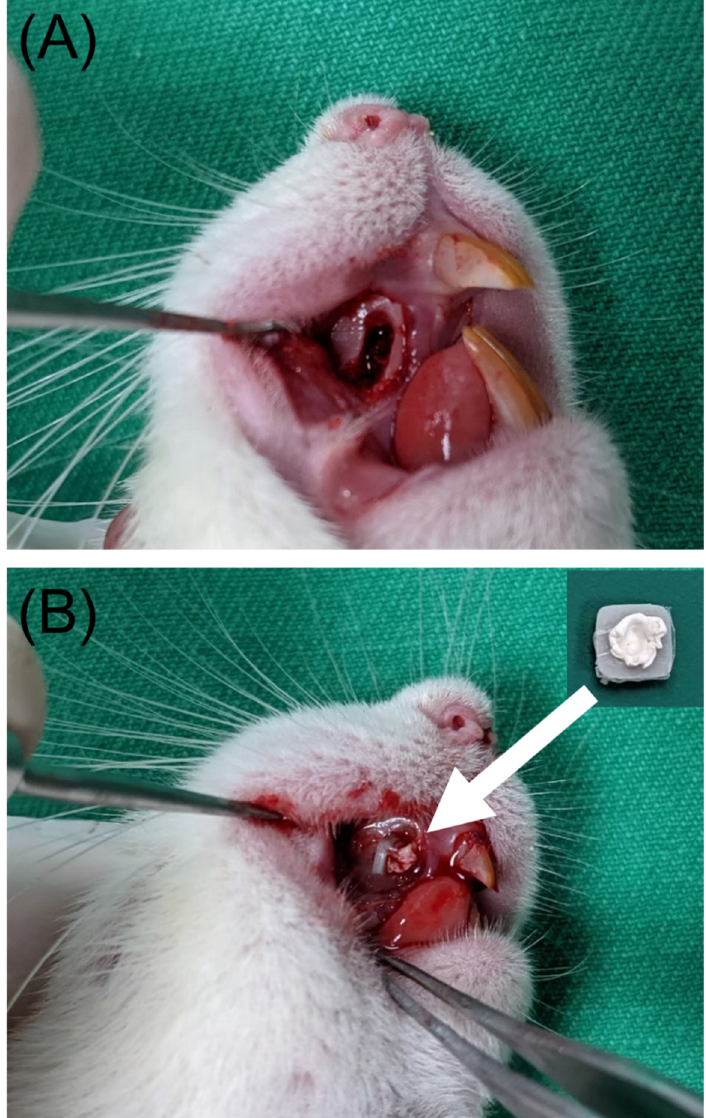
Figure 2. ( A ) Creating a bone cavity at the alveolar bone, ( B ) implantation of the drug- and biomolecule-incorporated nanofibrous scaffold in the bone cavity.